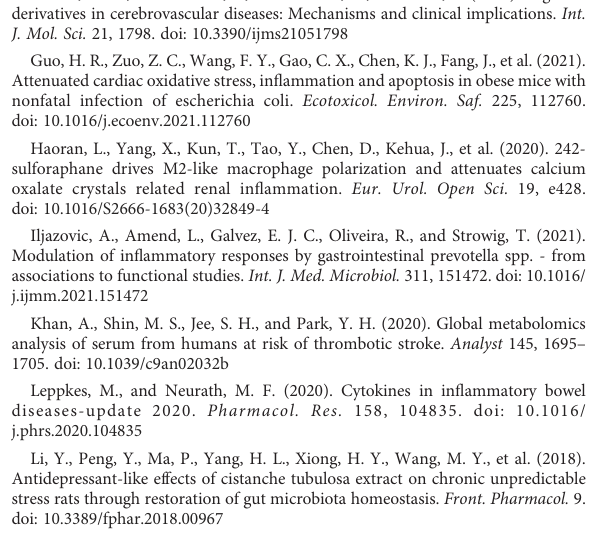
SUPPLEMENTARY FIGURE 1 Images of brain by TTC staining (A) ; Quanti fi ed data of TTC staining presented in ischemia volume (%) (B) . * P < 0.05, ** P < 0.01. SUPPLEMENTARY FIGURE 2 PCA of QC and test samples. ( A : PCA plot score in positive, the green dots stands for QC samples, the blue dots stands for test samples; B : One- dimensional distribution diagram of QC samples in positive mode; C : PCA plotscoreinnegativemode,thegreendotsstandsforQCsamples,theblue dots stands for test samples; D : One-dimensional distribution diagram of QCsamplesinnegativemode).(Forinterpretationofthereferencestocolor in this fi gurelegend, the reader is referred to the web version of this article.) SUPPLEMENTARY FIGURE 3 The correlation analysis of QC sample in positive and negative mode. SUPPLEMENTARY FIGURE 4 Total ion chromatogram in SG, CIRI, NMDP, IG 8d and IG 14d samples in negative ion mode. SUPPLEMENTARY FIGURE 5 Total ion chromatogram in SG, CIRI, NMDP, IG 8d and IG 14d samples in positive ion mode. SUPPLEMENTARY FIGURE 6 The OPLS-DA score plot and OPLS-DA permutation plot in negative mode. SUPPLEMENTARY FIGURE 7